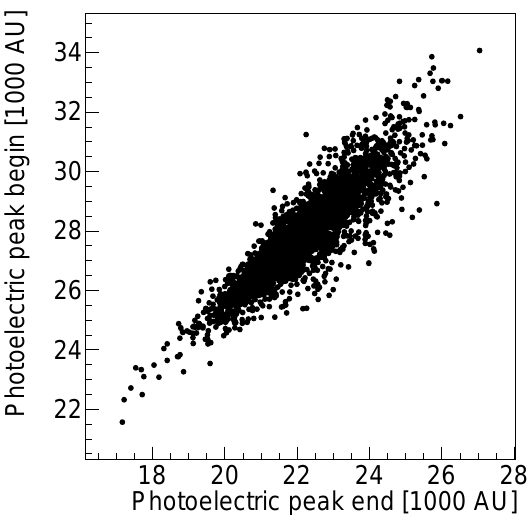
Figure 9. Position of the 511 keV photoelectric peak taken at a time distance of ten